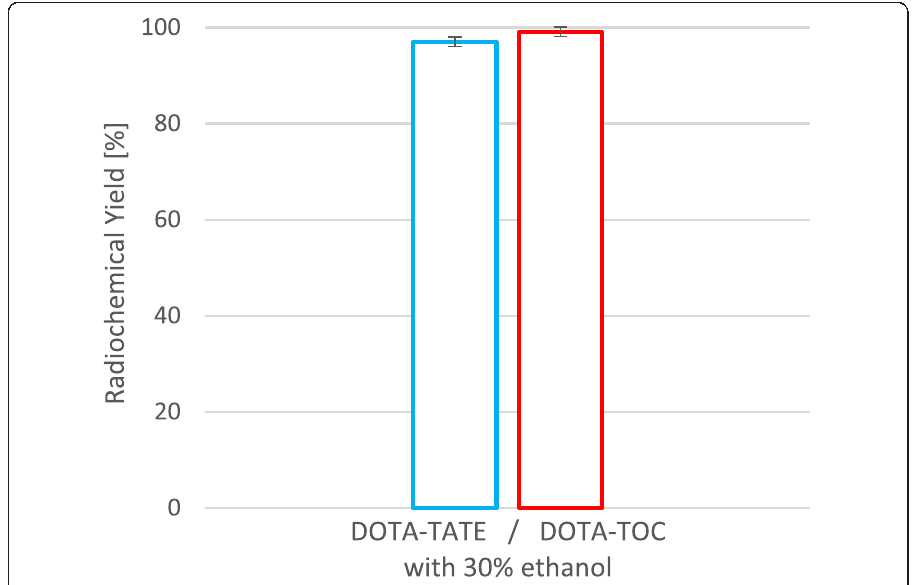
Fig. 5 Comparison of the mean radiochemical yield values of DOTA-TATE and DOTA-TOC with 30 vol% ethanol. 10 μ g (6.96 nmol) DOTA-TATE or 10 μ g (7.03 nmol) DOTA-TOC, T = 95 °C, t = 420 s, 500 μ l eluent solution, 0.52 ml 0.5 M ammonium acetate buffer (pH 4), overall pH 3.6 – 3.8. All experiments were